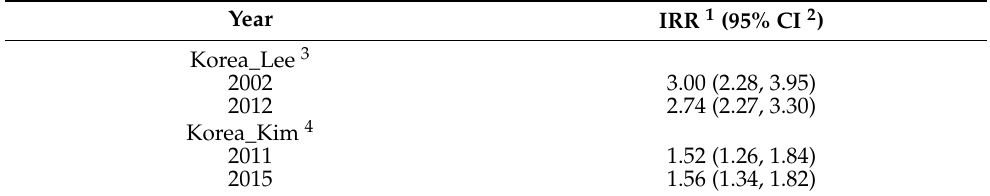
Table 3. Taiwan-to-Korea incidence rate ratios.